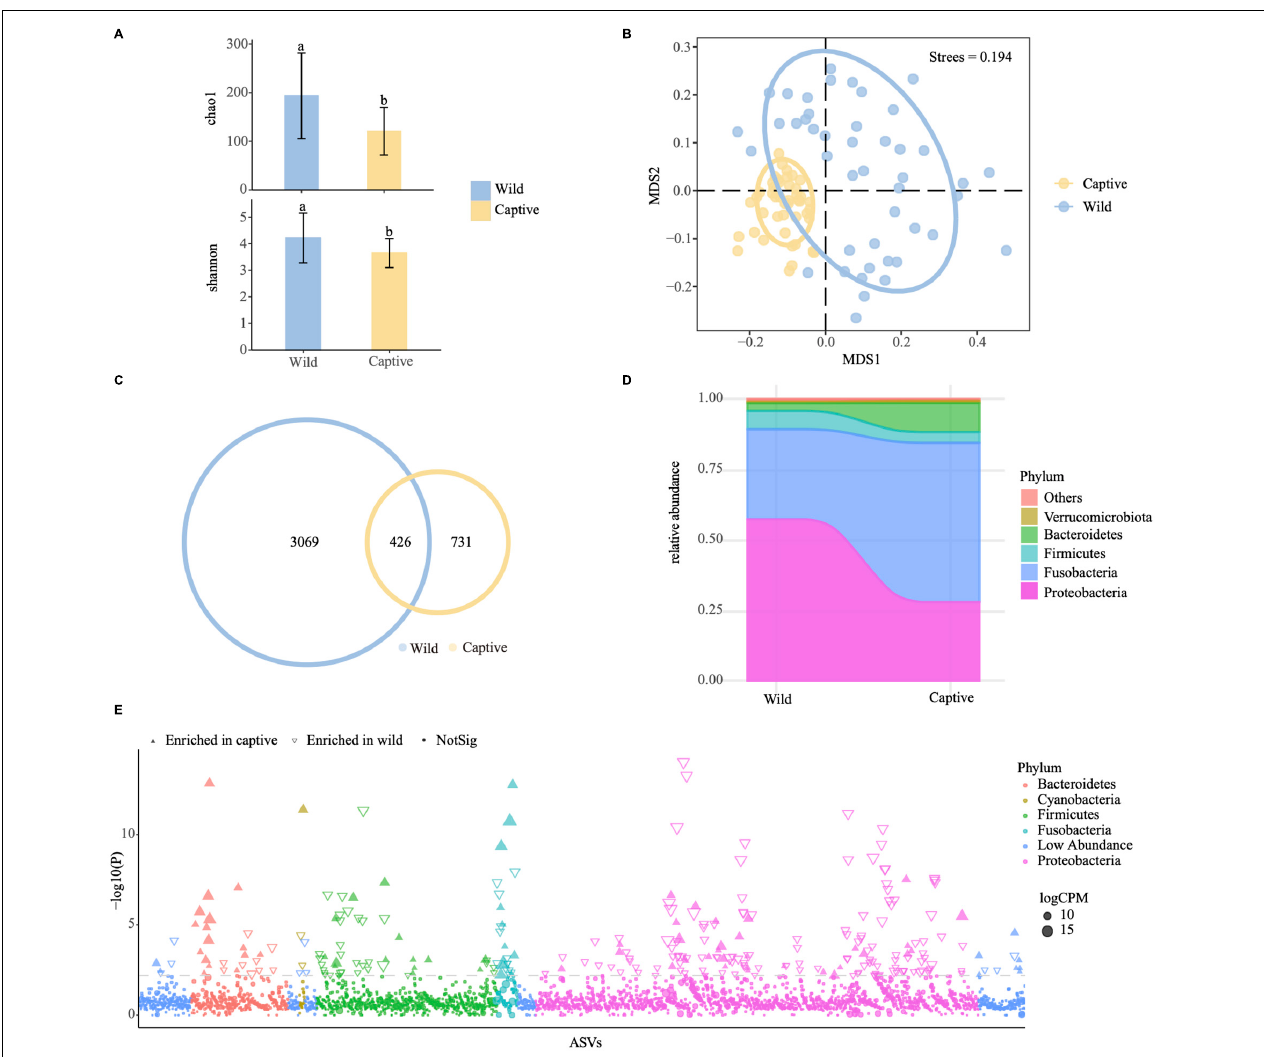
FIGURE 5 | Effect of captivity on the gut microbiota of Sinocyclocheilus species ( N = 24). (A) Chao1 and Shannon indices for gut samples from wild and captive populations. Letters represent significant difference between the groups ( P < 0.05, ANOVA, Tukey HSD test). Data bars represent mean and error bars represent the standard error of the mean. (B) Non-metric multidimensional scaling (NMDS) analysis with Bray–Curtis distances, showing gut bacterial composition across the captive and wild cavefishes ( P < 0.001, ANOSIM test). The ellipses cover 80% of data for each fish sample. (C) Venn diagram showing unique and shared ASVs between the captive and wild fish populations. (D) Distribution of gut bacterial taxa in captive and wild fishes at phylum level. (E) Manhattan plot showing ASVs enriched in the gut of captive and wild fish populations. Each dot or triangle represents a single ASV. ASVs enriched in captive and wild groups are represented by filled or empty triangles, respectively [false discovery rate (FDR) adjusted P < 0.05, Wilcoxon rank-sum test]. ASVs are arranged in taxonomic order and colored according to the phylum; counts per million reads mapped. Replicated samples are as follows: wild group ( N = 46), captive group ( N = 46). A total of 17 species of Sinocyclocheilus